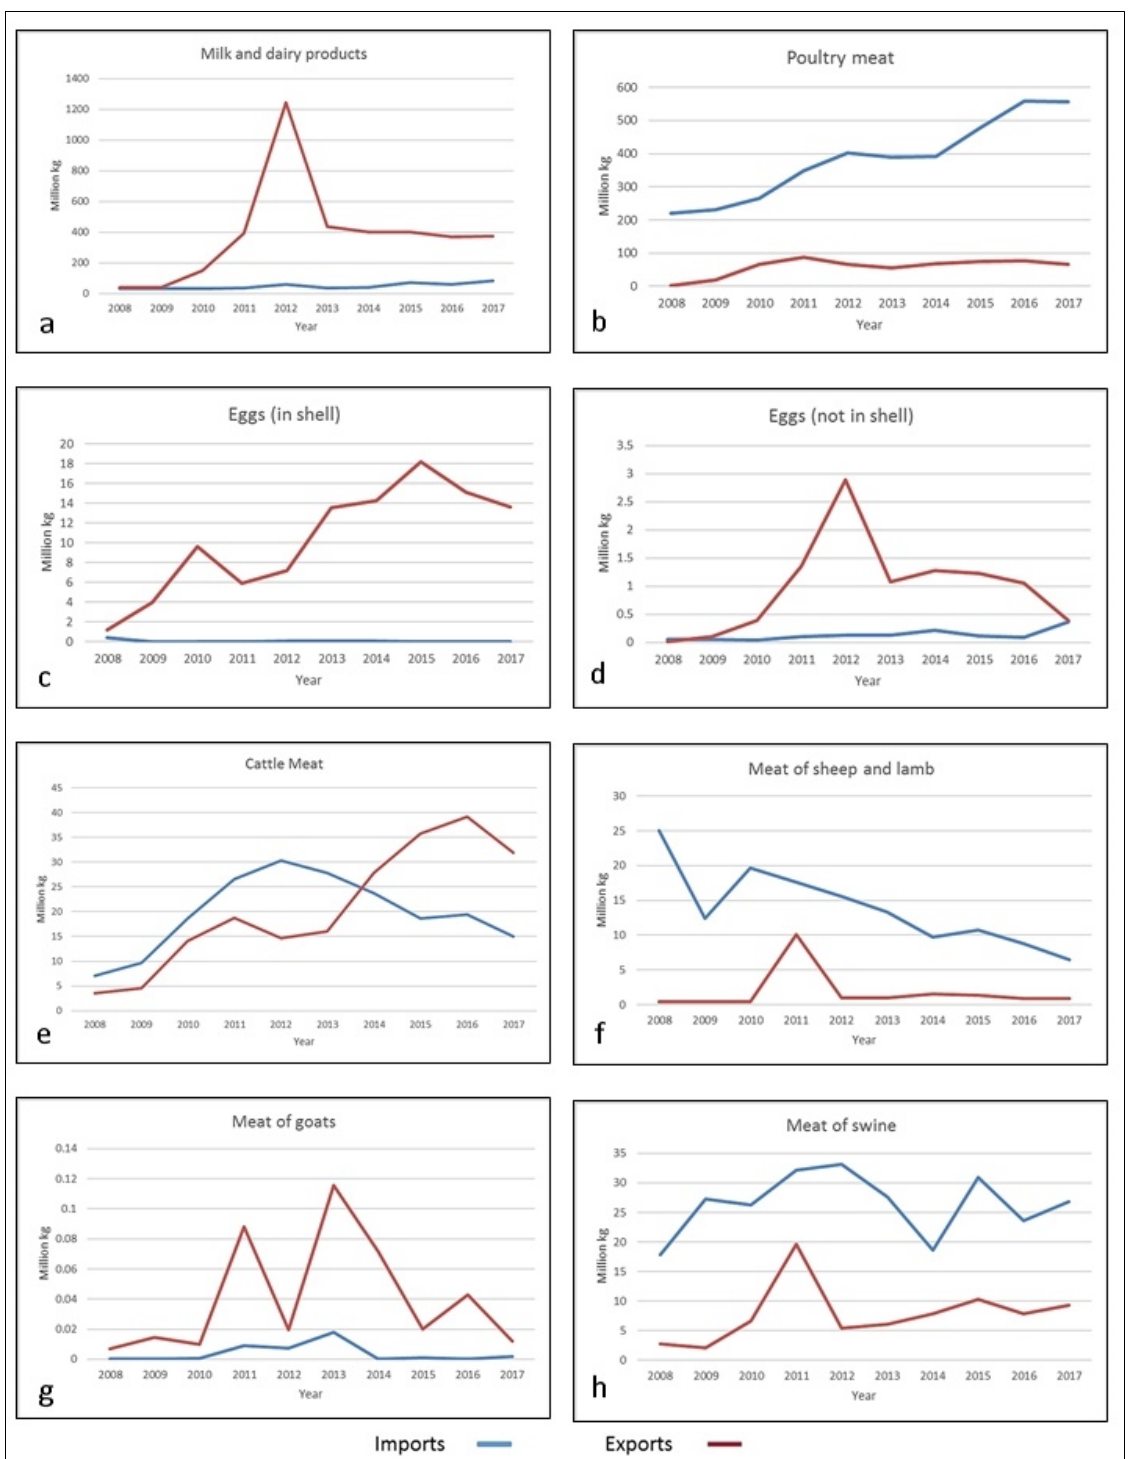
Figure 3. Import and Export Quantities of LDF in Million Kgs, 2008–2017